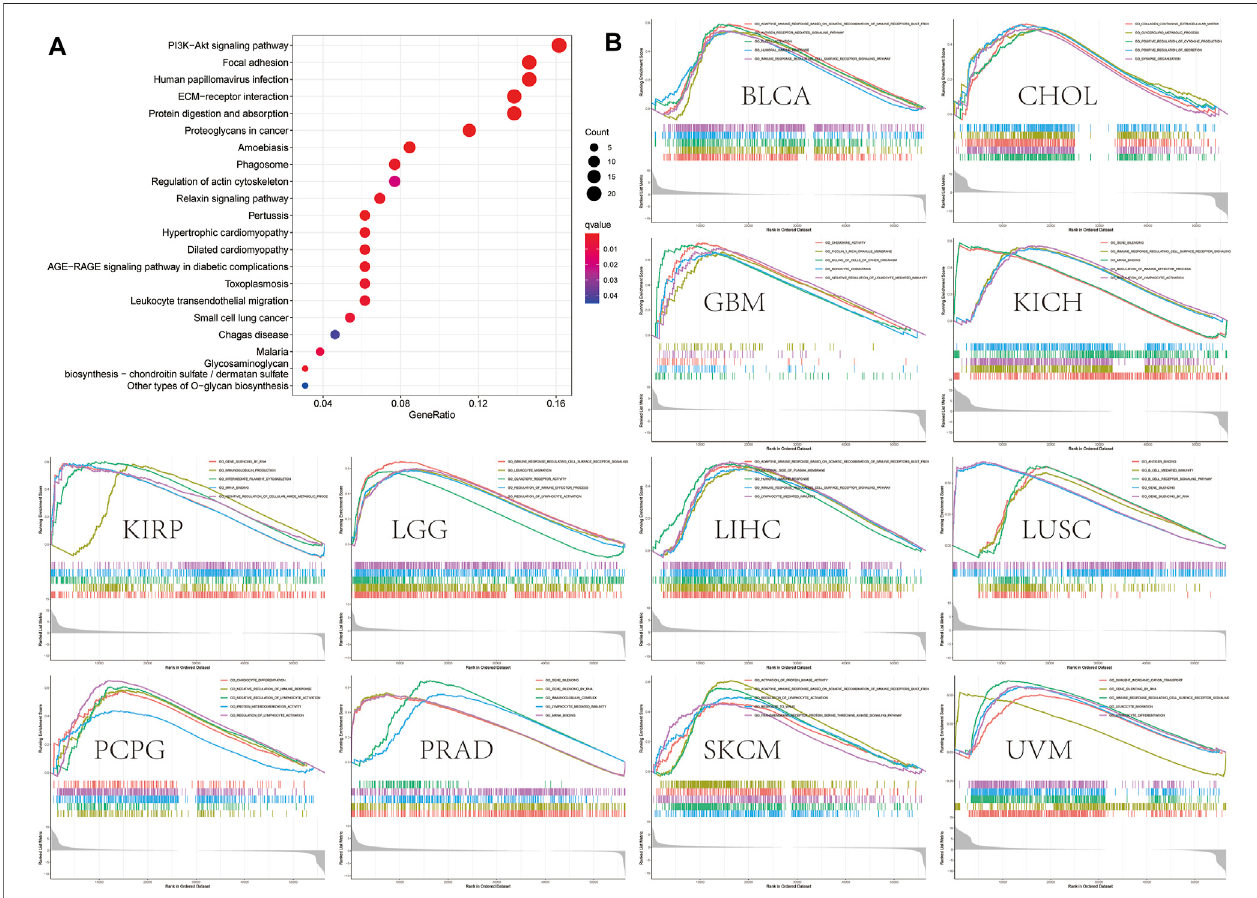
FIGURE 6 | OLFML2B-associated gene enrichment analysis. (A) KEGG pathway analysis of OLFML2B-correlated genes. (B) GO analysis of OLFML2B.